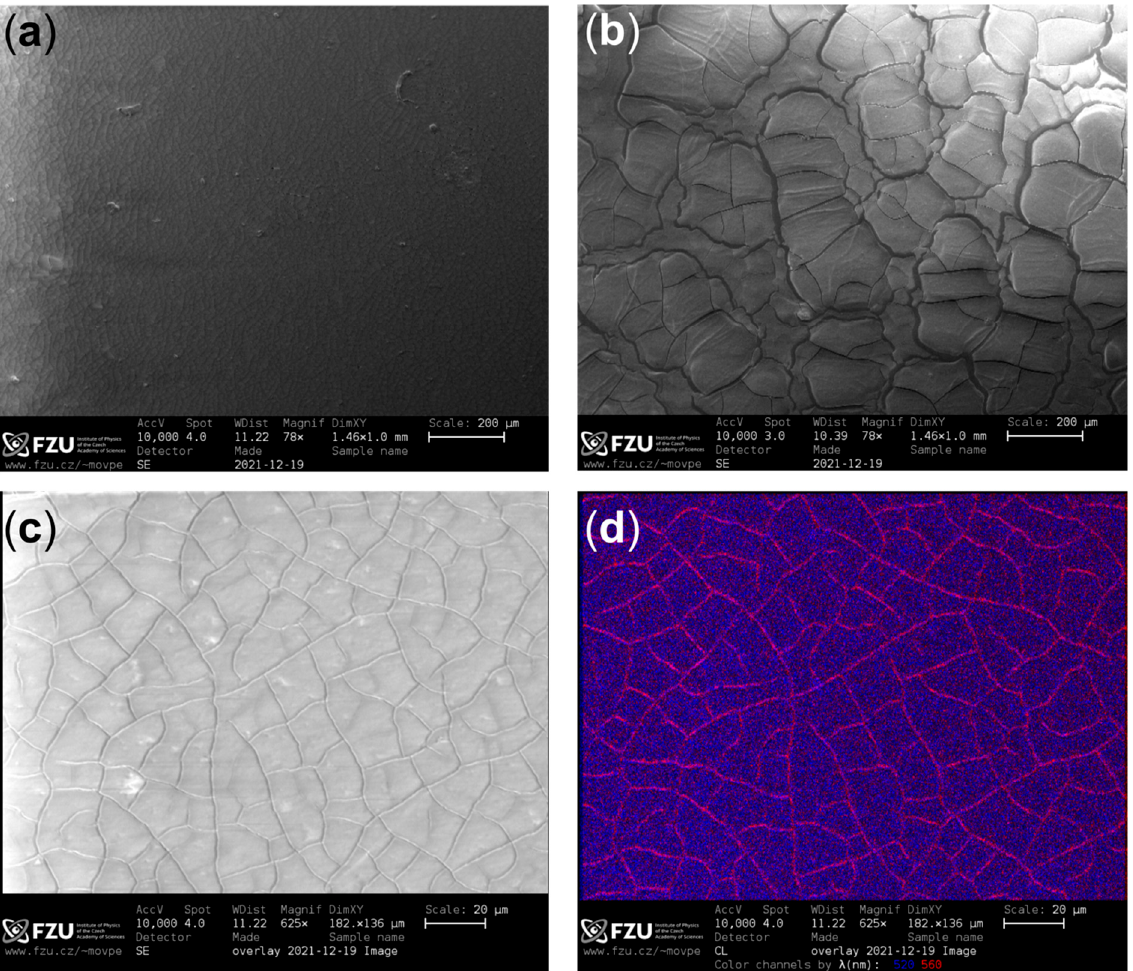
Figure 5. SEM images of the CsPbBr 3 film on GGAG:Ce prepared by the static ( a ) and dynamic ( b ) methods at very low magnification (78×). SEM image ( c ) and cathodoluminescence (CL) image ( d ) of the film prepared by the static method at larger magnification (625×). Red color in the CL image represents the 560 nm light (which is emitted from GGAG:Ce) and blue color the 520 nm light (which is emitted mostly by CsPbBr 3 ).